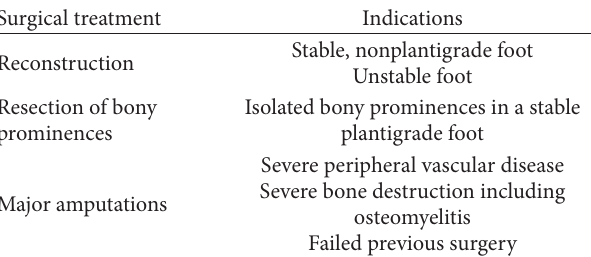
Table 3: Indications of the surgical